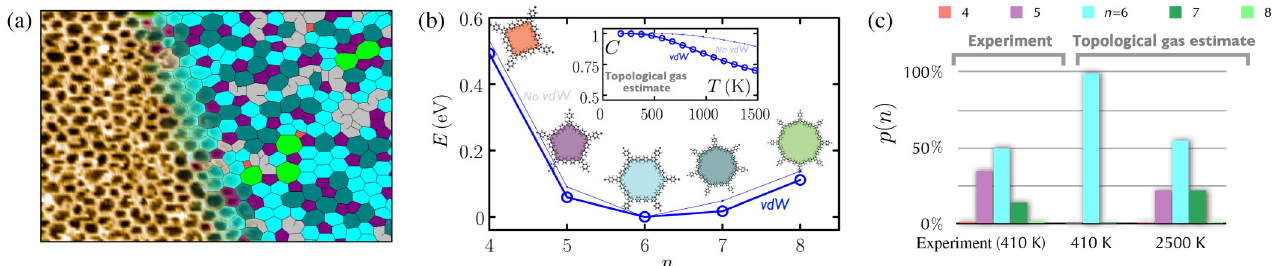
FIG. 2. Analysis of one example from Fig. 1 reveals the microscopics of polygon formation. (a) Image of TBPB acquired using a scanning tunneling microscope fading to polygon representation (Fig. S1). (b) DFT calculations with (vdW-DF2) and without (B3LYP) van der Waals forces show the relative energy per TBPB molecule when bound in isolated, regular n -gons. Using this estimate of polygon thermodynamics in a topological-gas estimate (inset) shows the equilibrium network to a perfect honeycomb up to about 500 K. (Crystallinity C is the fraction of the polygon network made up of hexagons [8].) (c) Histogram of the polygon number from the experiment and as predicted in equilibrium (using the topological-gas model) at two temperatures indicates that the network seen in the experiment is not in equilibrium, and so is a kinetically trapped polygon